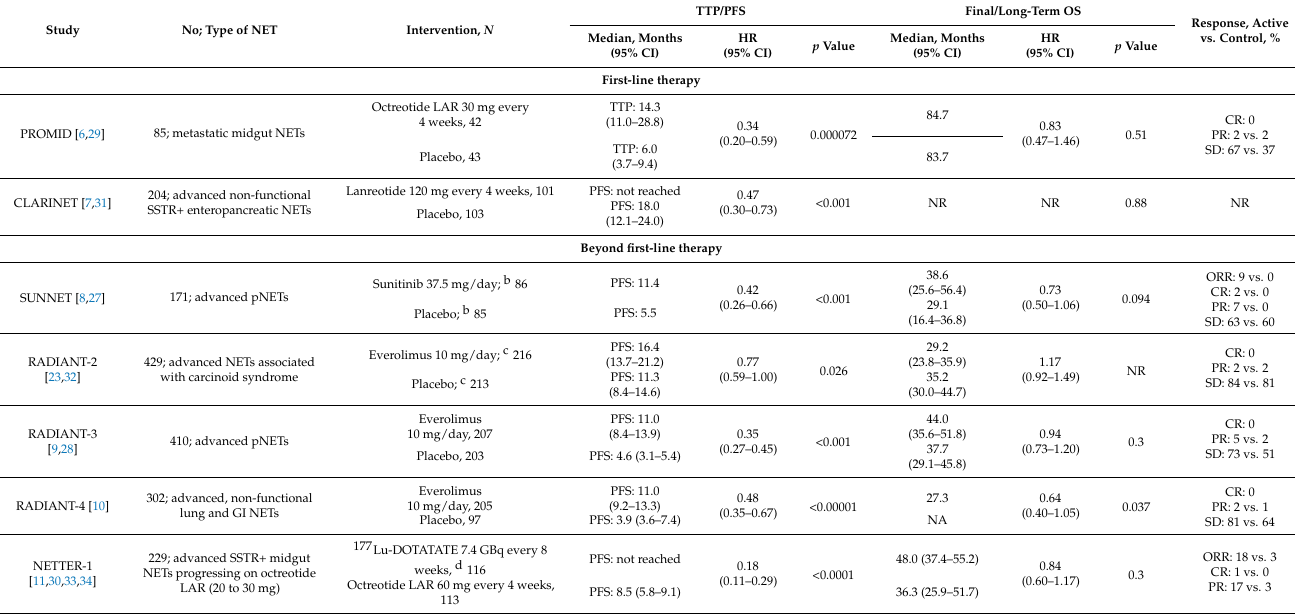
Table 1. Efficacy of systemic treatments for advanced NETs a